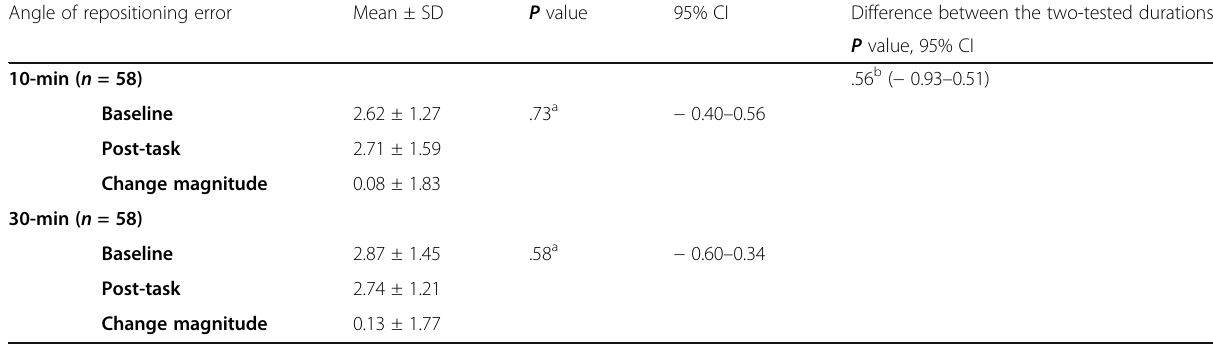
Table 3 Lumbar active position sense acuity as measured by the repositioning error angle (RE)